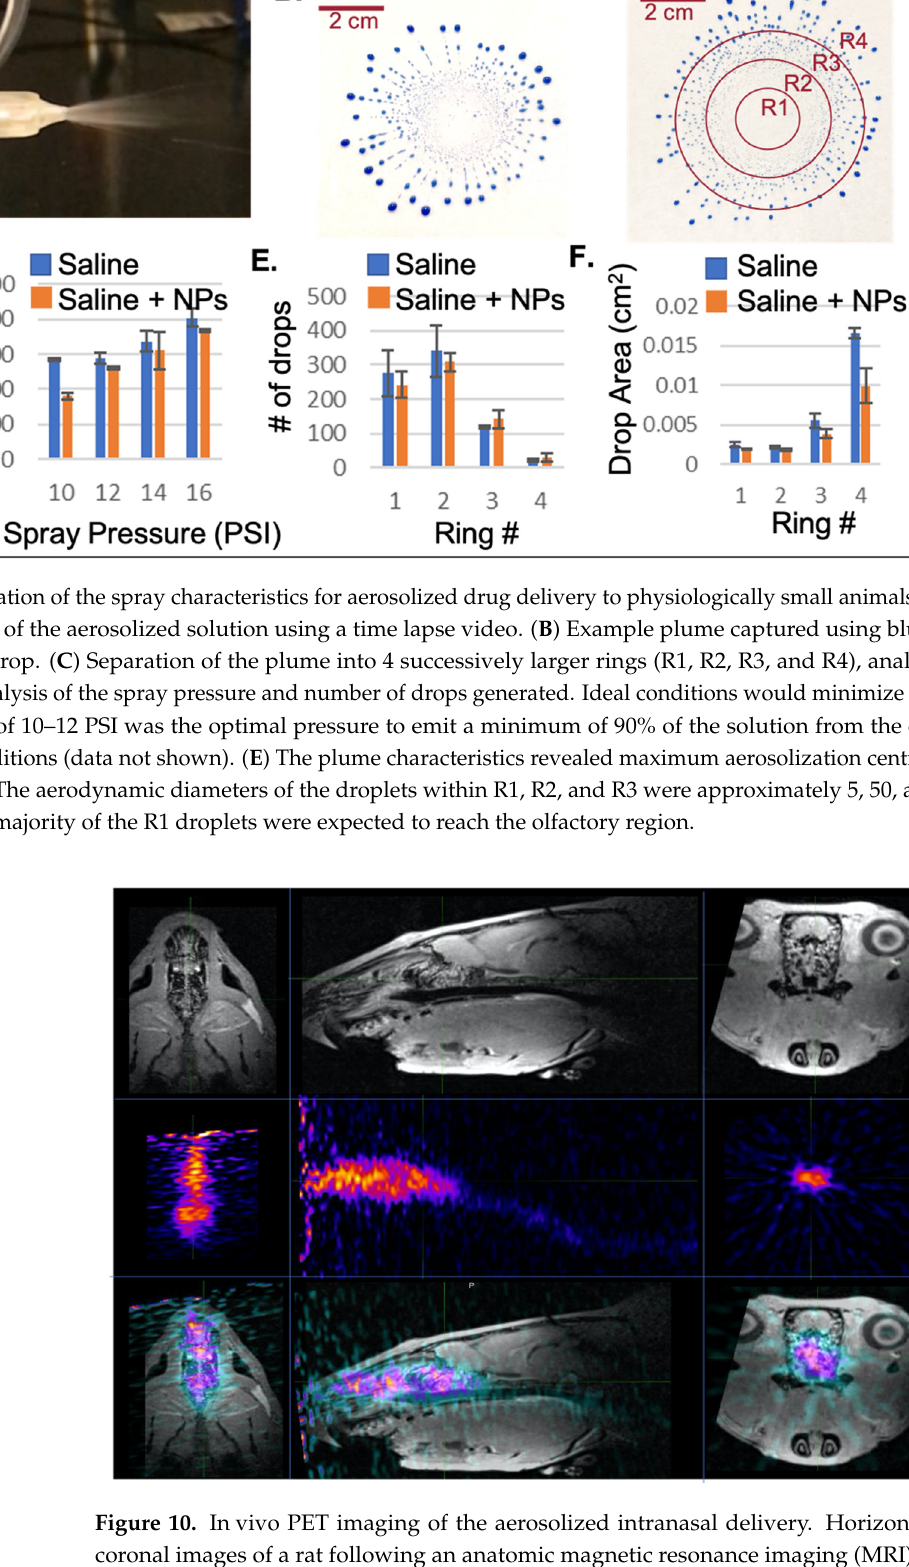
Figure 8. Quantitative brain region activity at 1 and 2 h following INDD of 100 nm PLA–PEG– 89 Zr NPs, as detected by gamma counting ex vivo. The percentage of initial activity per gram of tissue was calculated using a standard gamma counter to determine the differential activity in various regions throughout the brain. Similar to the PET/CT data, the signal activity was highest in the olfactory region and brainstem following INDD of the 100 nm PLA–PEG– 89 Zr NPs. Relatively less activity was seen in the forebrain.